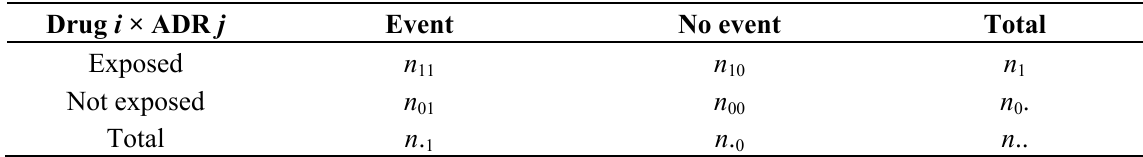
Table 2. 2 × 2 contingency table containing frequencies of exposure to drug i and occurrences of adverse drug reaction (ADR) j as basis for signal